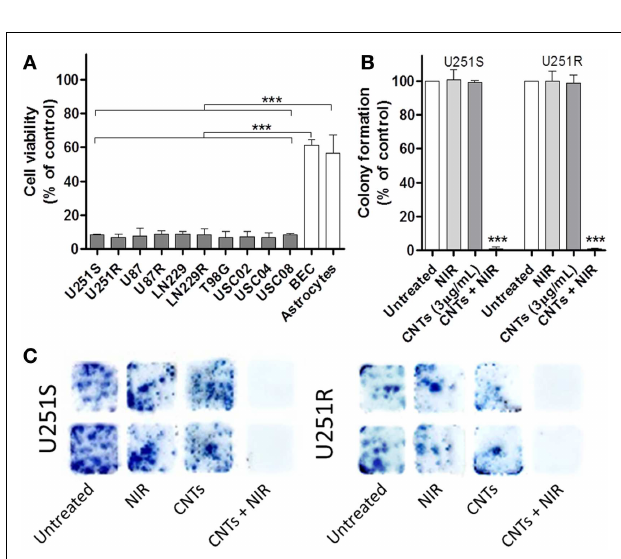
FIGURE 4 | Effects of CNTs and NIR on several different glioma cells compared to normal cells . (A) GBM cell types (U251S, U251R, U87, U87R, LN229, LN229R,T98G), GBM cancer stem cells (USC02, USC04, USC08) and normal cells (human BEC and astrocytes) were treated with CNTs (3 µ g/mL) and a single NIR treatment (10min at 6.75W/cm 2 ). After 5days, cell viability was evaluated using the MTT assay. Normal cells demonstrated greater viability compared to tumor cells ( n = 3, *** p < 0.001). (B) U251 drug-sensitive and drug-resistant (U251R) cells were treated as described above. After 10days, the numbers of colonies were significantly reduced in CNTs (3 µ g/mL) plus NIR (10min at 6.75W/cm 2 ) treated cells ( n = 3, *** p < 0.001); (C) Representative images of the colonies are